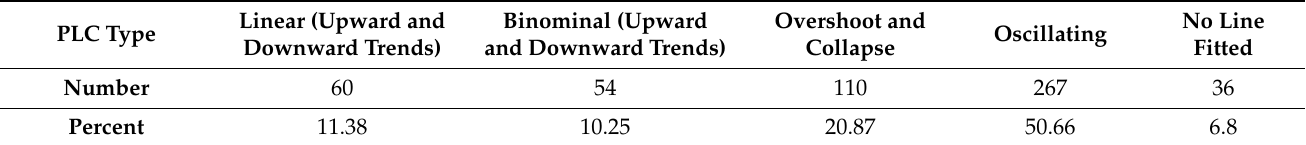
Table 1. Different pattern of product life cycle in the generic pharmaceutical products.